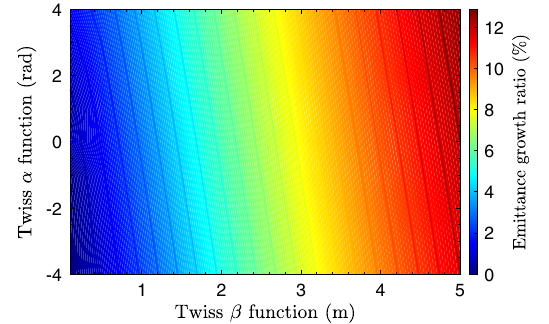
FIG. 4. Emittance growth ratio for a wide range of initial Twiss β and α obtained by ELEGANT tracking simulation. Solid lines indicate the ratios calculated by the linear suppression condition obtained from Eqs. (1), (2) [23].